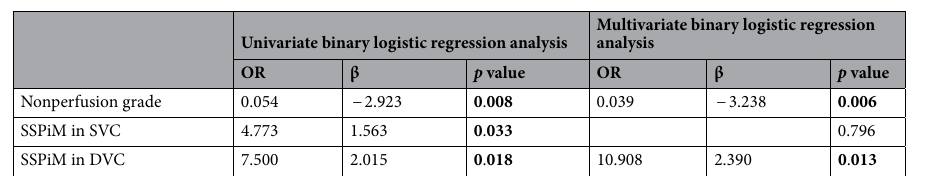
Table 3. Binary logistic regression analysis of cyst treatment response. OR odds ratio, SSPiM suspended scattering particles in motion, SVC superficial vascular complex, DVC deep vascular complex.